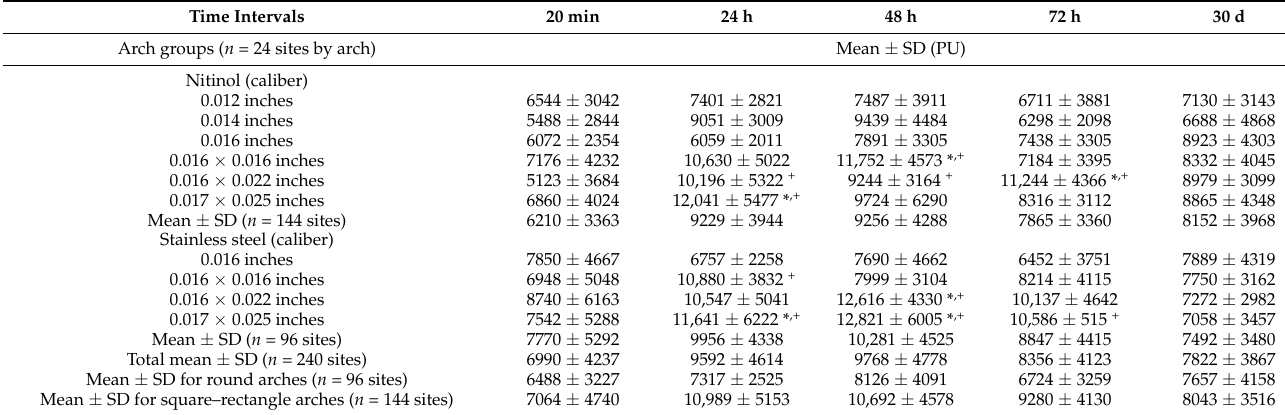
Table 2. Evaluation of the integrated total secondary real flow (ITSRF) in patients with orthodontic treatment (Nitinol and steel arches) at different time intervals.